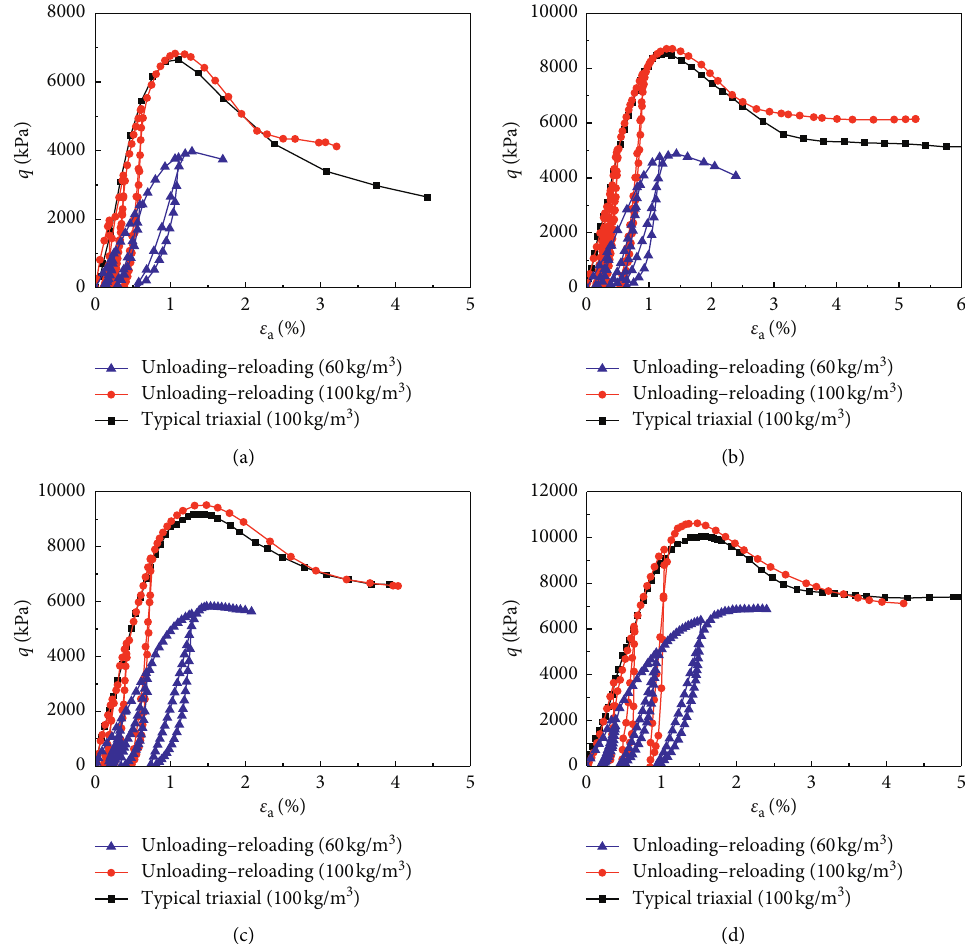
Figure 3: LCSG material stress-strain curves for different confining pressures. (a) 300kPa. (b) 600kPa. (c) 900kPa. (d)